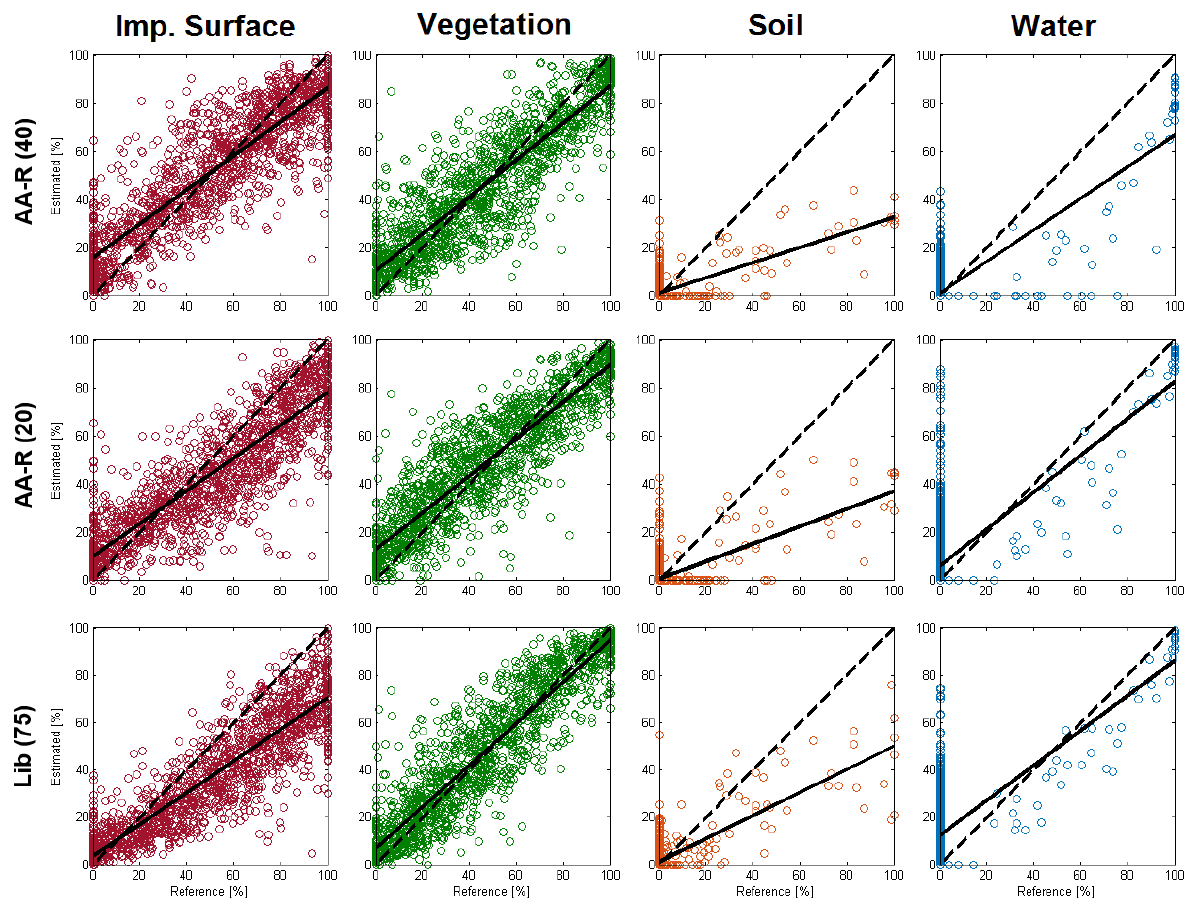
Figure 2. Scatter plots representing the class-wise fraction estimates of impervious surface , vegetation , soil and water , opposed to the reference fractions. A correct estimated pixel lies on the dashed line. The solid line represents the respective least-square regression line for the scatter